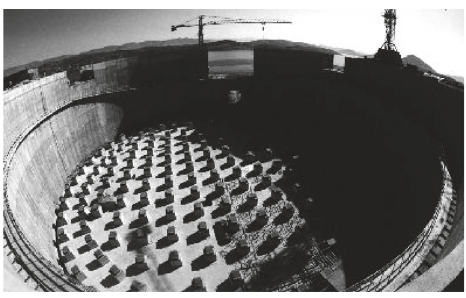
Figure 1: Isolated LNG tank (Tajirian,